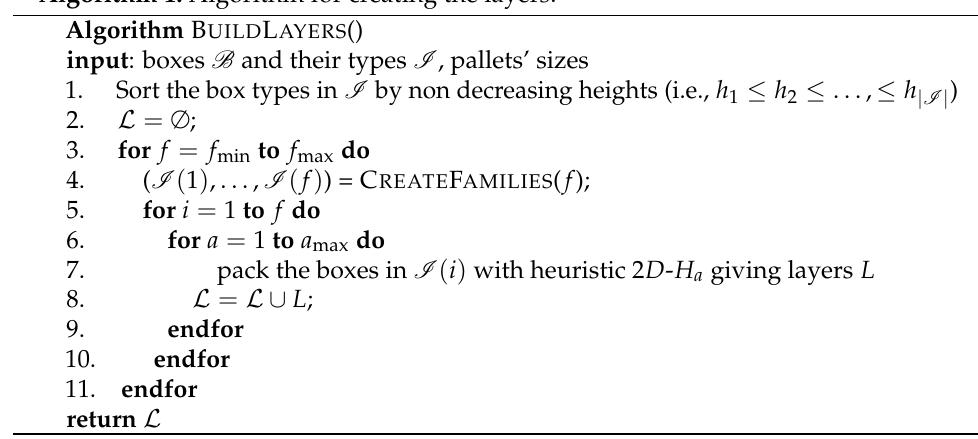
Algorithm 1: Algorithm for creating the layers.